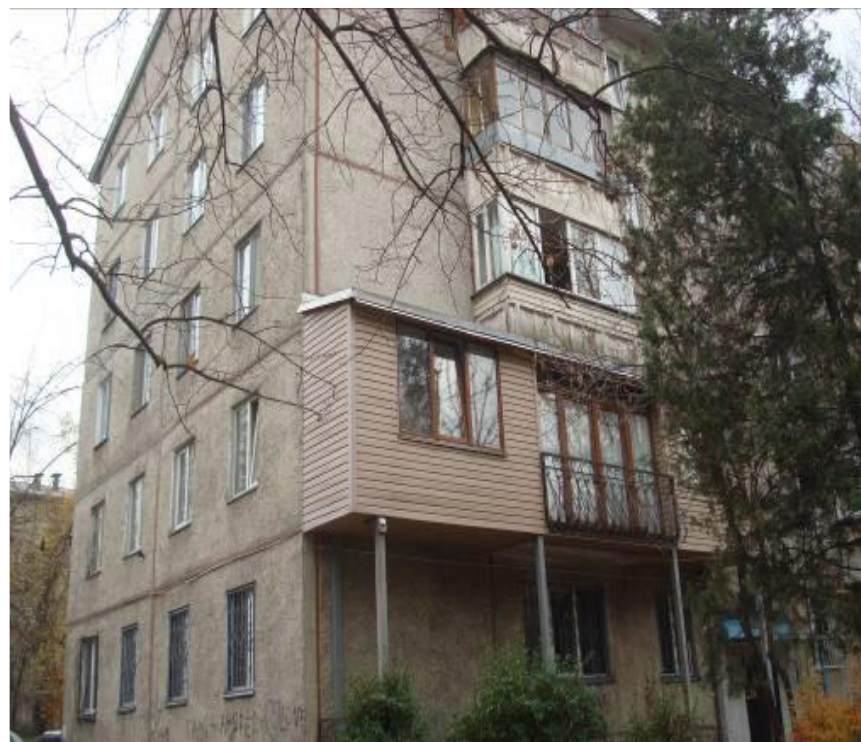
Figure A2. Precast concrete wall panel.